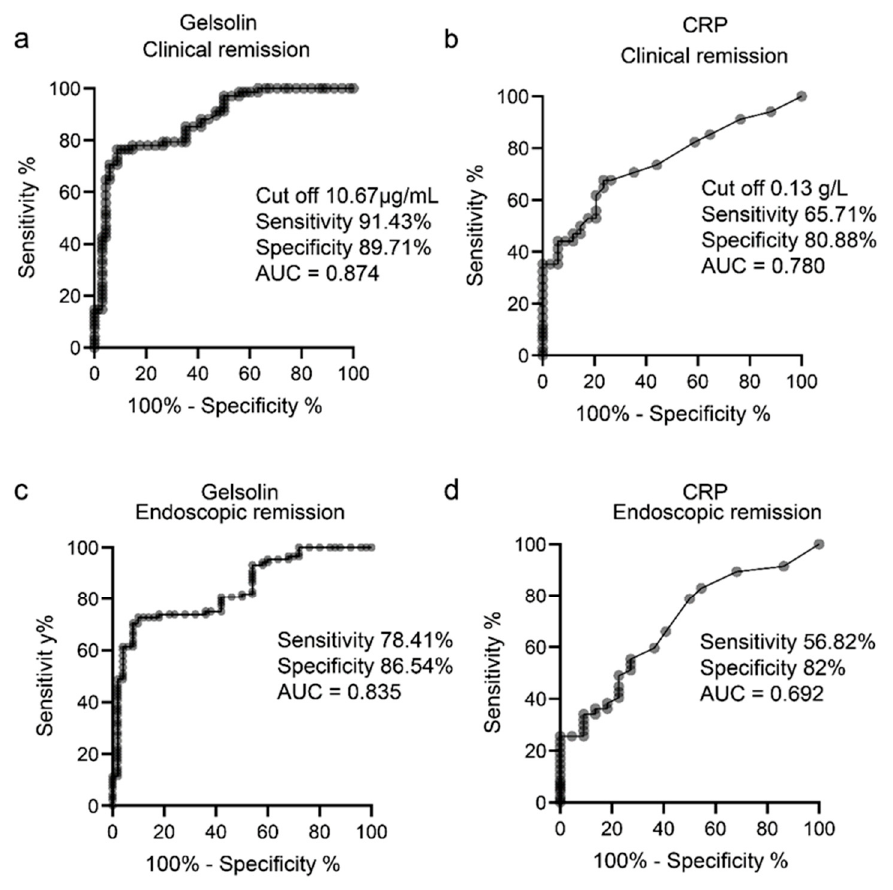
Figure 3. GSN level reflects clinical and endoscopic activities in patients with UC. Receiver operating characteristic (ROC) curves for GSN and CRP indicating their sensitivity and specificity in discriminating ( a , b ) clinical remission and ( c , d ) endoscopic remission.